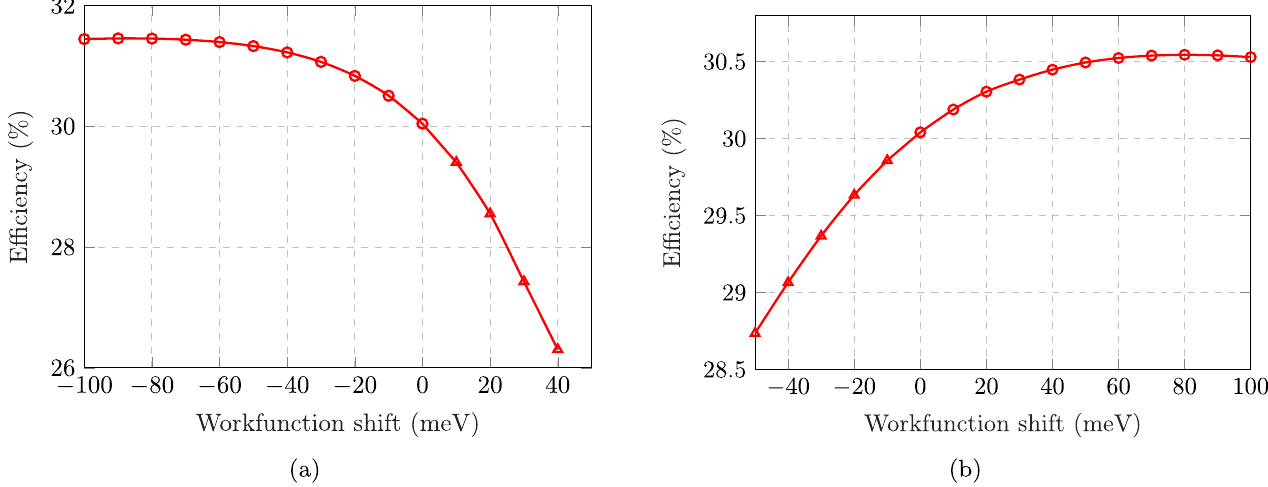
Fig. 16. (a) Tandem cell ef fi ciency as function of top perovskite energy level shift near the perovskite/HTL interface. (b) Tandem cell ef fi ciency as function of bottom perovskite energy level shift near the perovskite/HTL interface. Both the conduction and valence bands are shifted by the same amount. In contrast to no shift in energy levels, circle and triangle marks show increase and decrease in the ef fi ciency,